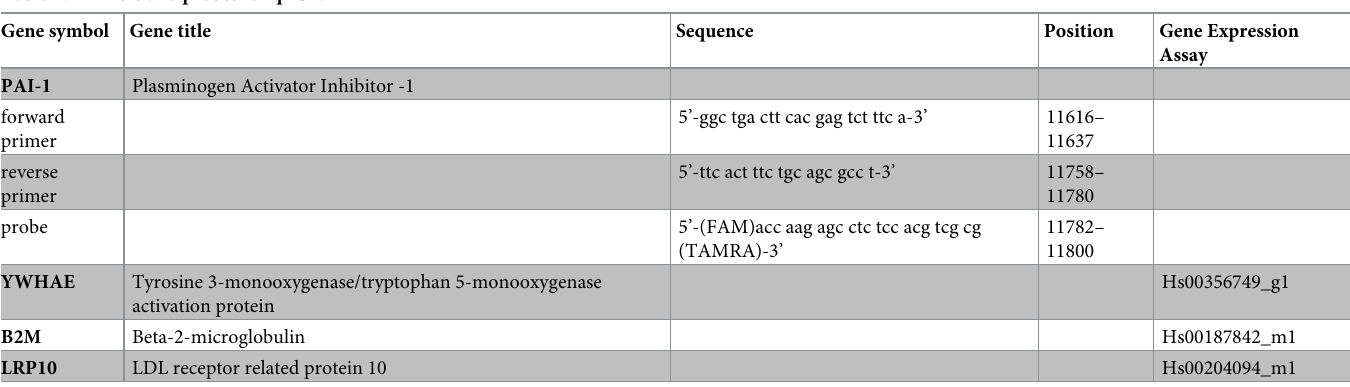
Table 1. Primers and probes for